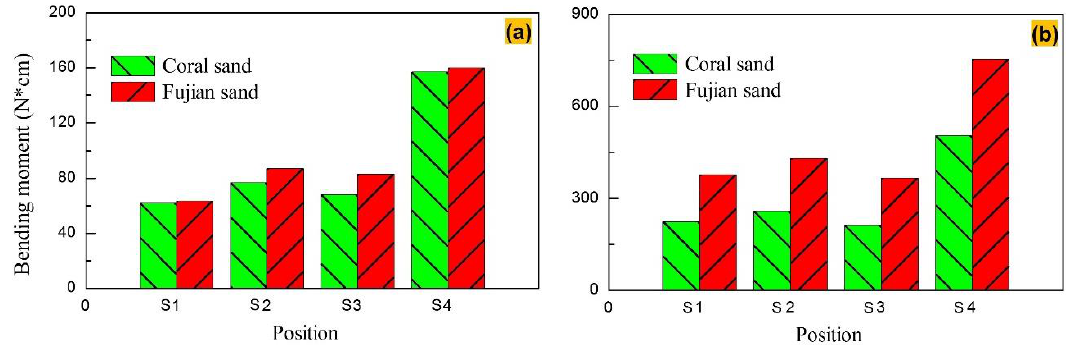
Figure 14. Peak column bending moments at different height: ( a ) 0.1 g shaking intensity; and, ( b ) 0.2 g shaking intensity.